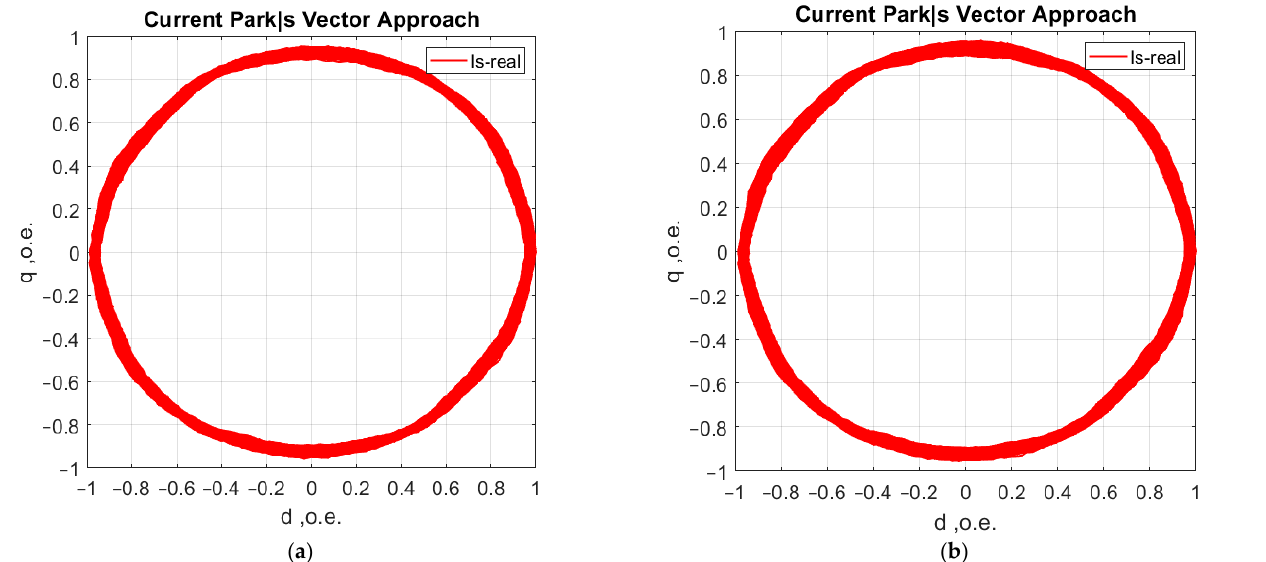
Figure 16. AM current consumption hodographs: ( a ) when recording A, B, C phase currents; ( b ) when recording A and C phase currents.